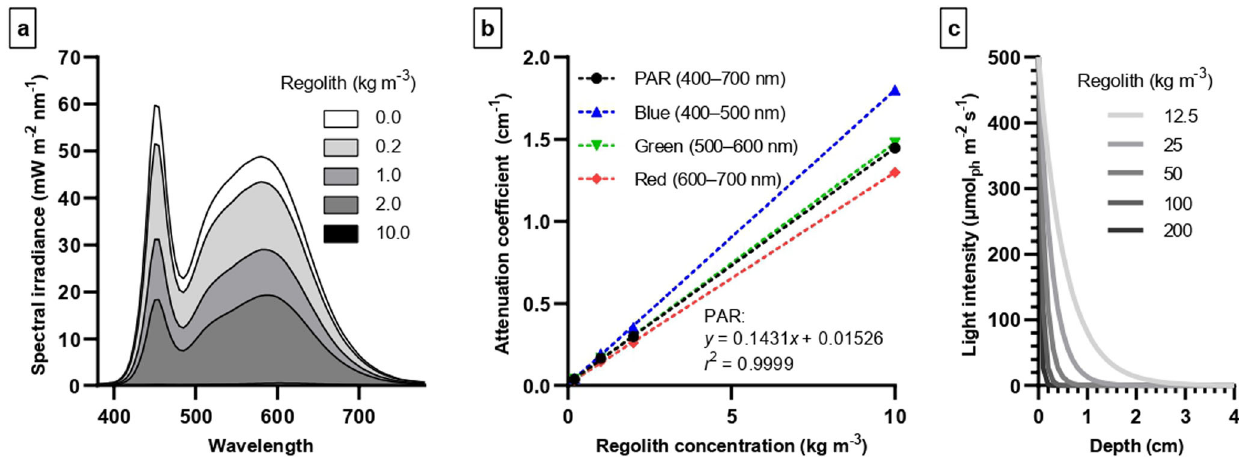
Fig. 4 Shading effect of suspended MGS-1. a Spectral irradiance measured underneath 3.3 cm of water, or of water containing MGS-1 (grain size <100 µm) at the indicated concentrations. b Attenuation coef fi cients of a suspension of MGS-1 in water, as a function of regolith concentration and for different spectral ranges (calculated from spectral irradiance measurements). c Light intensity as a function of depth, for different concentrations of suspended regolith, assuming an intensity of 500 μ mol ph m − 2 s − 1 at the surface (calculated from the PAR attenuation coef fi